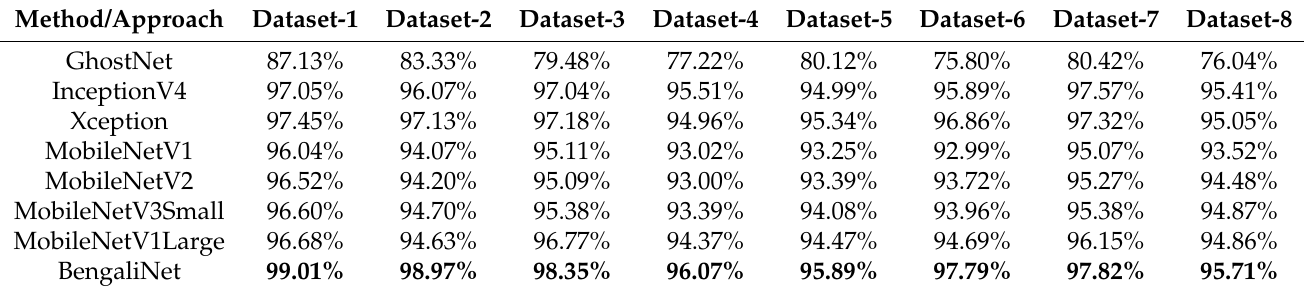
Table 8. Comparison among results obtained by our proposed BengaliNet and popular CNN